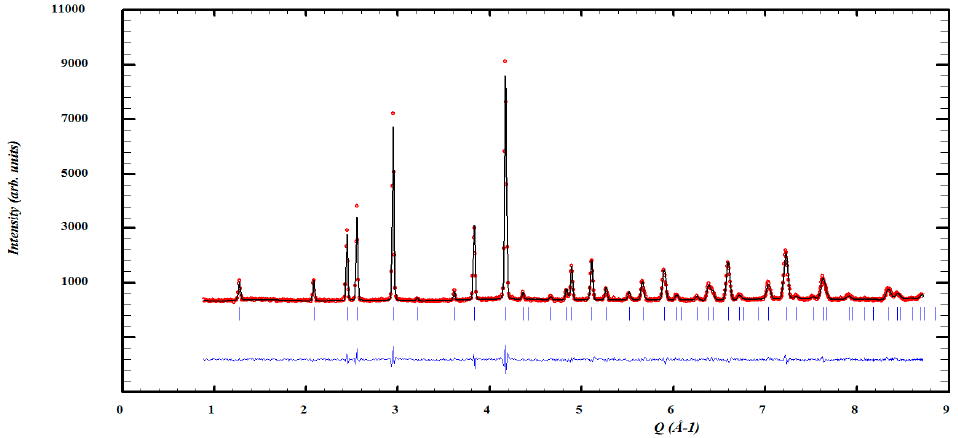
Figure 2. Observed and calculated ND diffraction patterns of Li 0.5 Zn 1.67 Sb 0.83 O 4 . Measurement statistics, background level, Q interval, and refinement reliability factors are in the usual range.